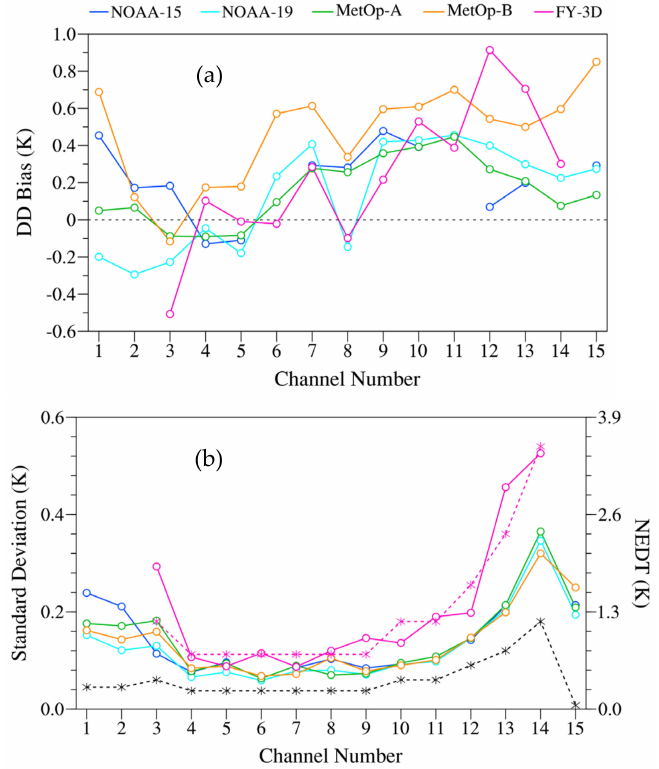
Figure 5. Variations in inter-sensor ( a ) double difference bias and ( b ) standard deviation with NEDT of AMSU-A (black dashed curve) and MWTS-2 (purple dashed curve) between NOAA-15/19, MetOp-A/B, FY-3D, and NOAA-18 for all AMSU-A